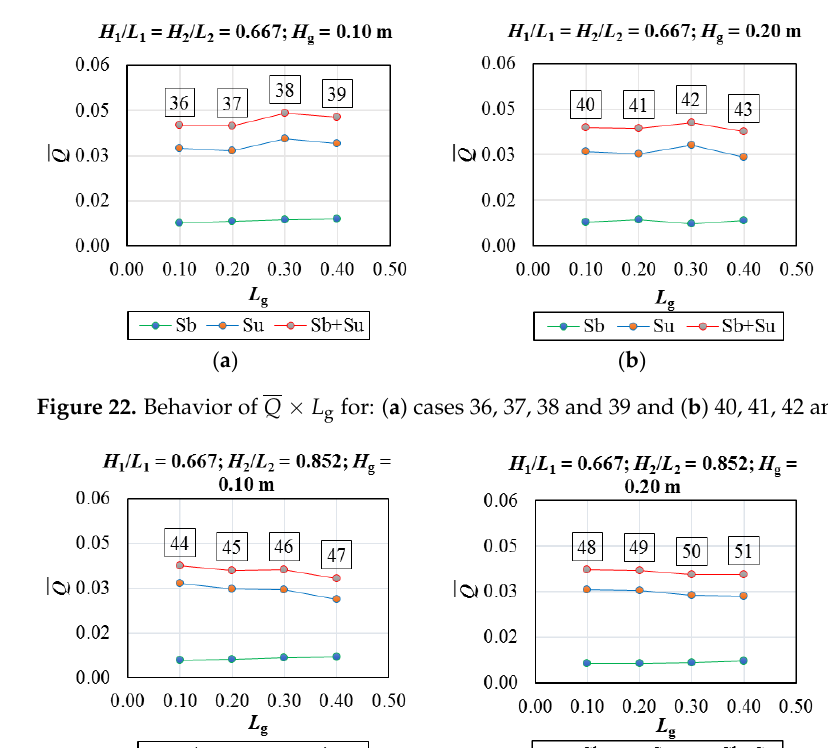
value of ( Q ̅ ) mm when compared with cases 12 and 63. Furthermore, for gauge Su, the curves had the same behavior for Figure 27a,b, with local maximums for H 2 / L 2 = 0.667; Figure 23. Behavior of Q ̅ × L g for: ( a ) cases 44, 45, 46 and 47 and ( b ) 48, 49, 50 and 51.